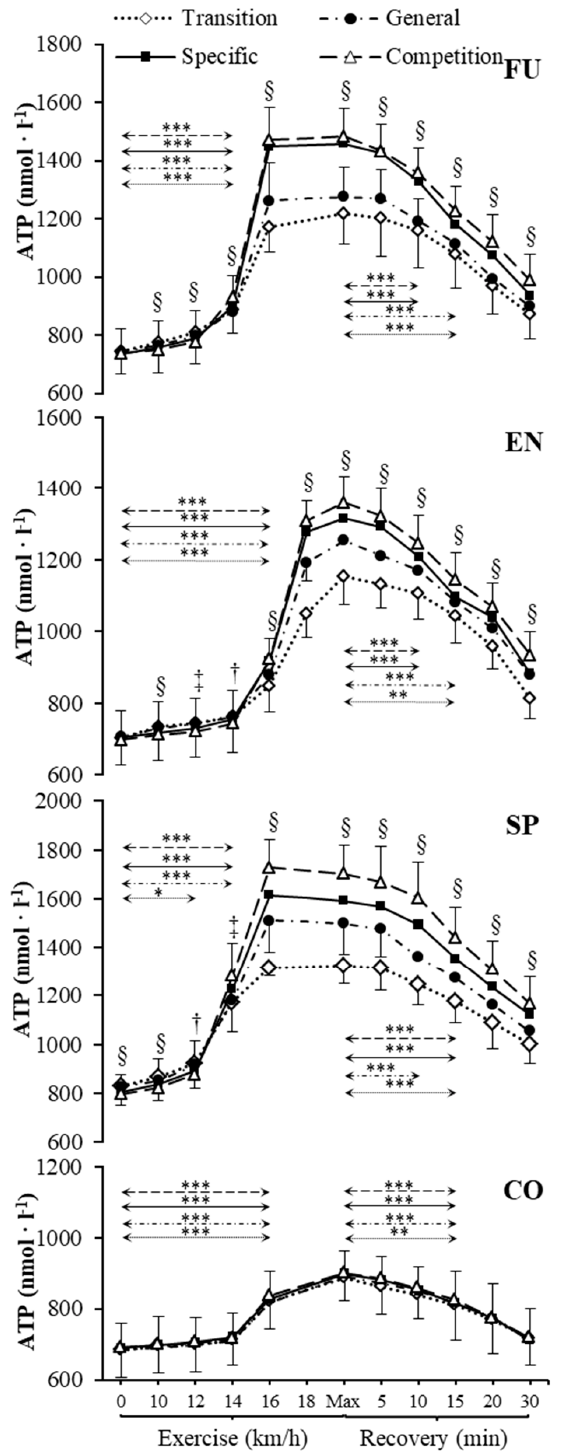
Figure 1. Venous plasma [ATP] before exercise, during incremental treadmill test until exhaustion, and post-exercise recovery in futsal players (FU; n = 11), endurance athletes (EN; n = 11), sprinters (SP; n = 11), and control group (CO; n = 11) in four consecutive training phases. Arrows indicate the first significant differences from samples taken at rest and maximal exercise within examinations. Significant differences between blood sampling points: *** p < 0.001, ** p < 0.01, * p < 0.05. Significant. differences between examinations at the same sampling point: § p < 0.001, ‡ p < 0.01, † p < 0.05. Data are presented as means ± SD.